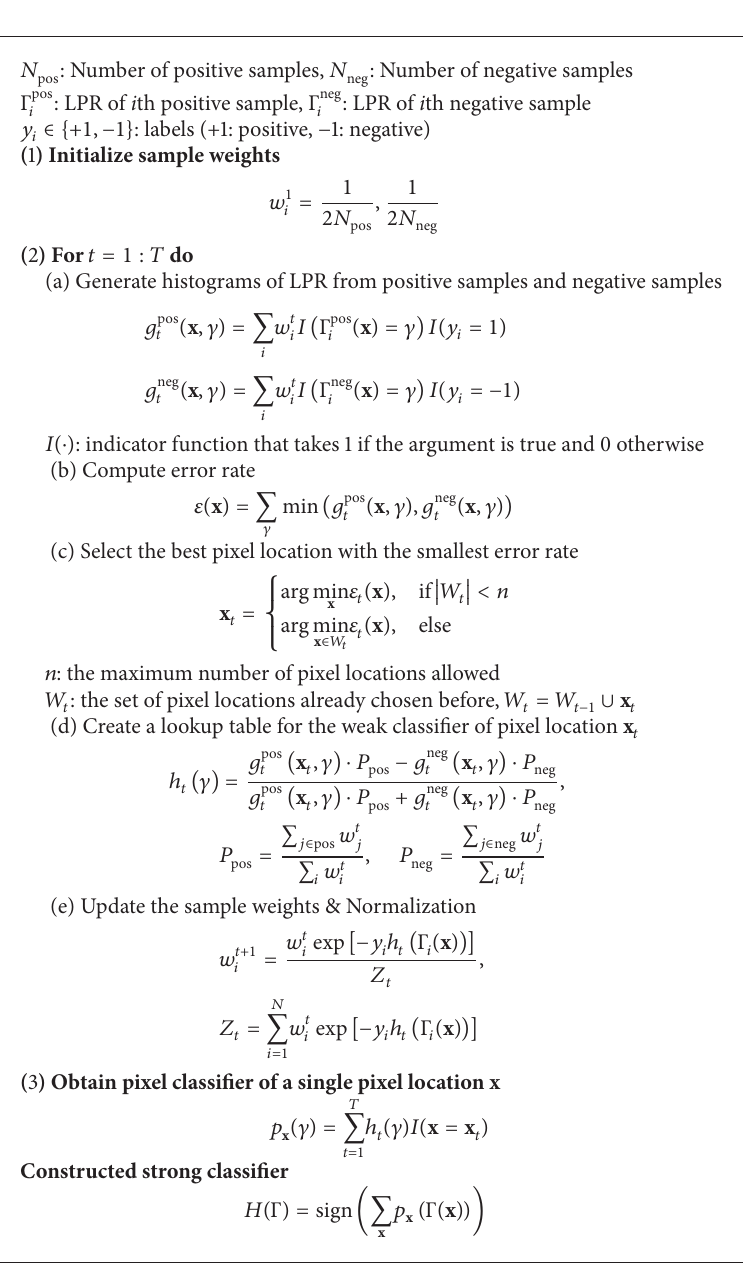
Algorithm 1: Proposed update procedure of a classifier based on a reinforced Adaboost